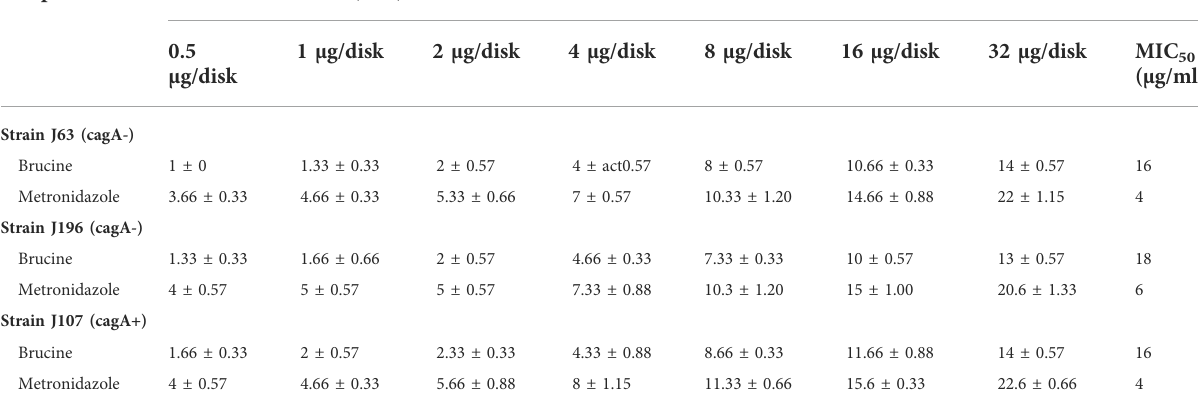
TABLE 2 Antibacterial effect of brucine against three clinical strains of H. pylori using the disk diffusion method. Sample